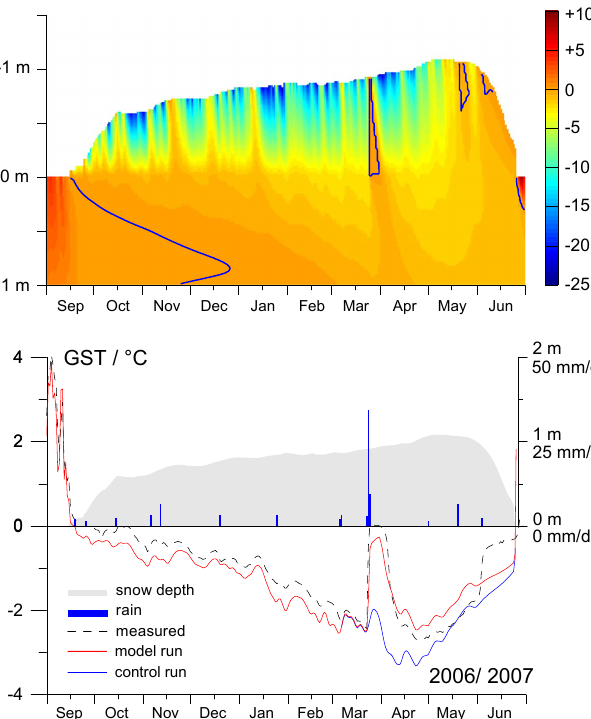
Fig. 4. Top: modeled temperature distribution (in ◦ C) within the snow pack and the first meter of soil for the winter season 2005/2006. The − 0.01 ◦ C isotherm is depicted in blue. Bottom: measured and modeled (including control run) ground surface tem- perature for the same time interval. In addition, the snow depth in m (right axis) and daily rainfall in mmd − 1 (as employed in the model runs) are displayed.